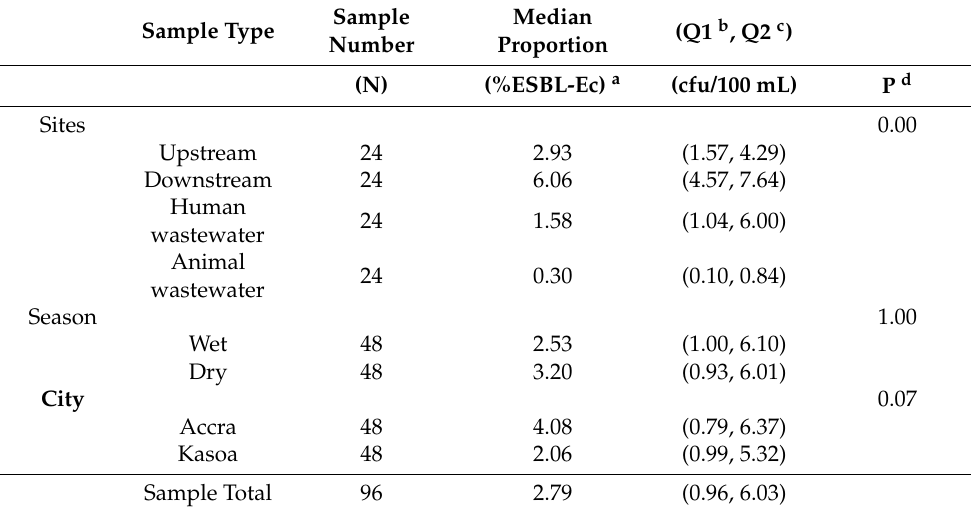
Table 4. %ESBL-Ec, stratified by site, city and season of water samples from Accra and Kasoa,